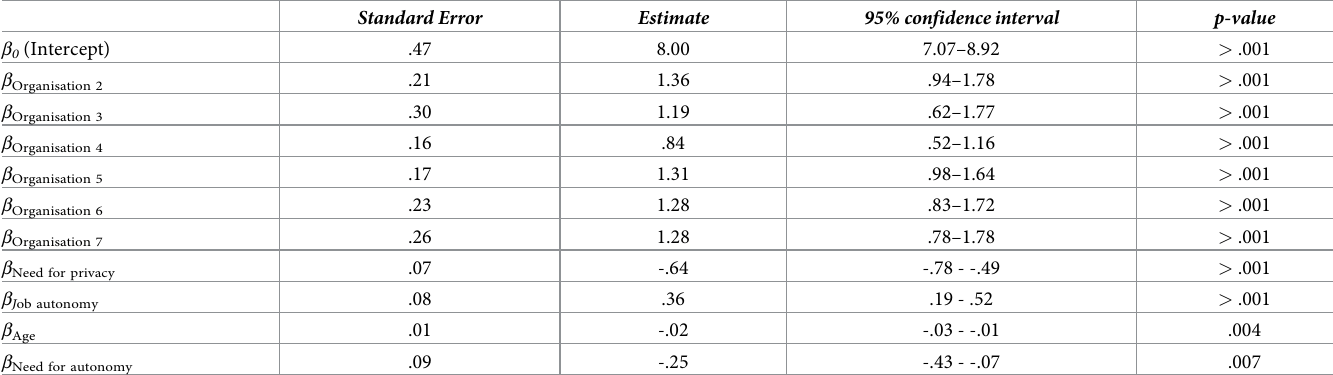
Table 4. Results of the final regression